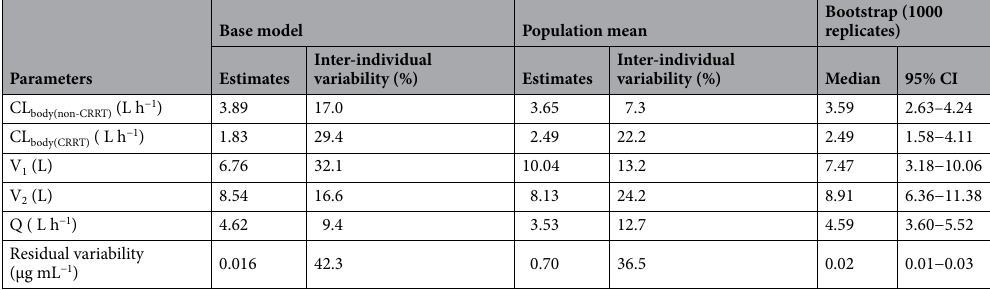
Table 3. Results of population pharmacokinetic parameters for the final model and for bootstrap sampling. CL